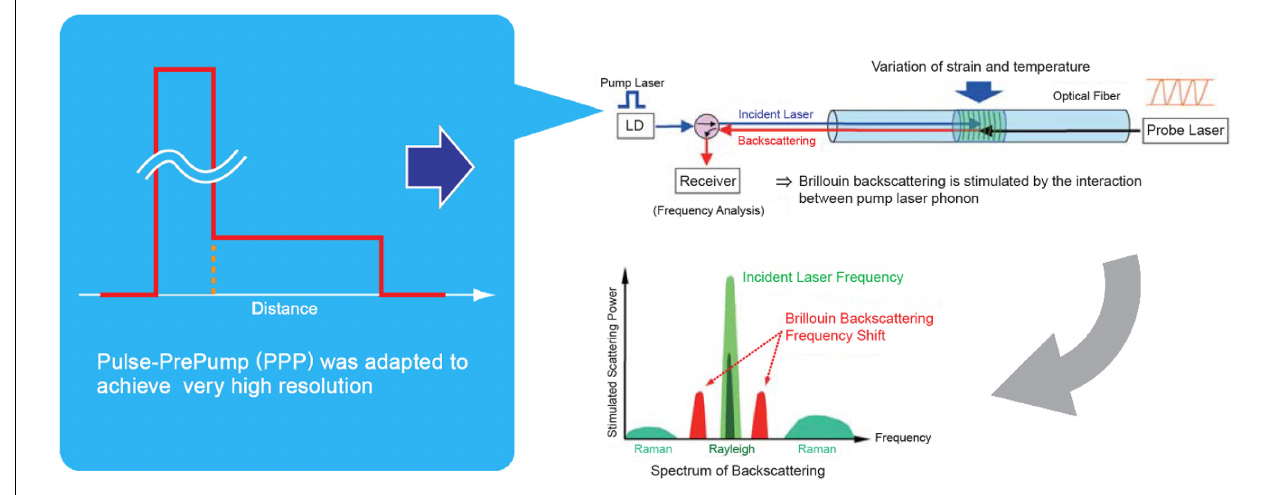
FIGURE 1 | Schematic diagram of the